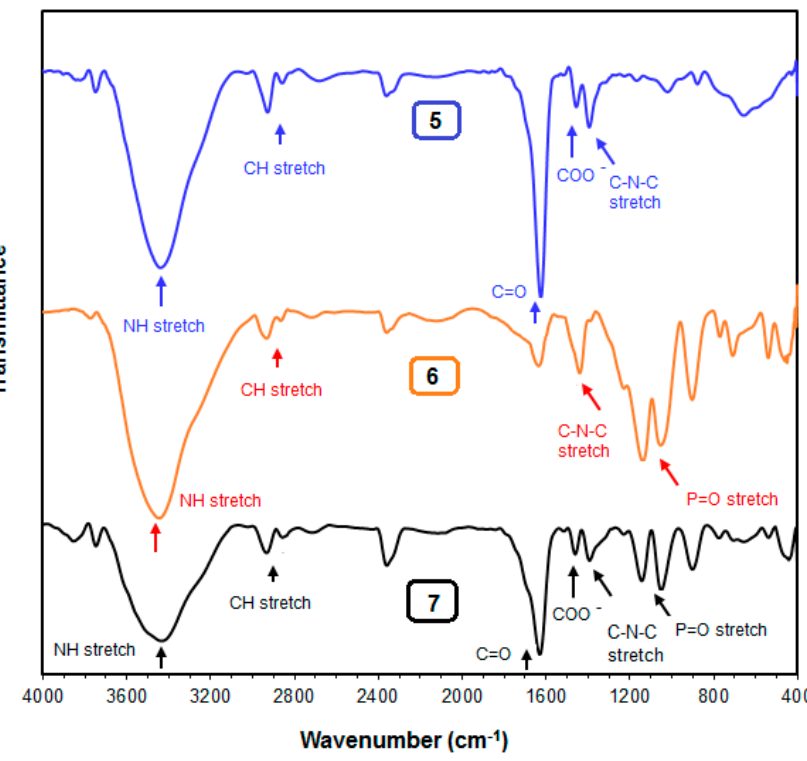
Figure 1. FT-IR spectra for the corrosion inhibitors 5 , 6 , and 7 .